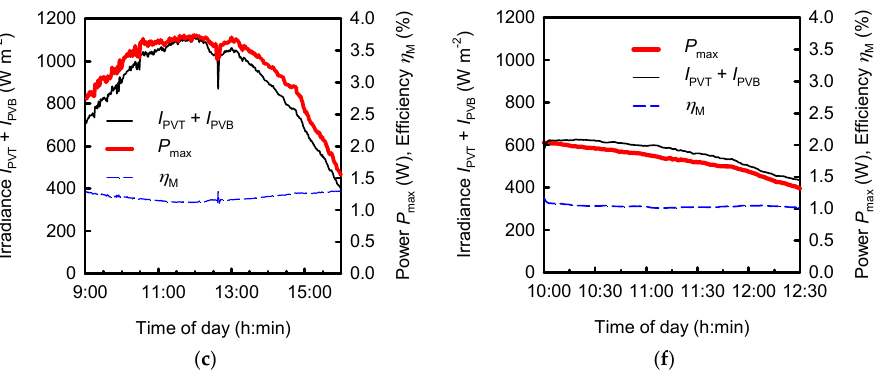
Figure 6. Electrical characteristics of the PV blind measured at the grass plot ( a – c ) or underneath the greenhouse roof ( d – f ): ( a , d ) horizontal global irradiance I H , global irradiance on the inclined top surface I PVT , and bottom surface I PVB ; ( b , e ) power–voltage characteristics of the PV blind; ( c , f ) bifacial incident irradiance I PVT + I PVB , peak power P max , and module efficiency η M .